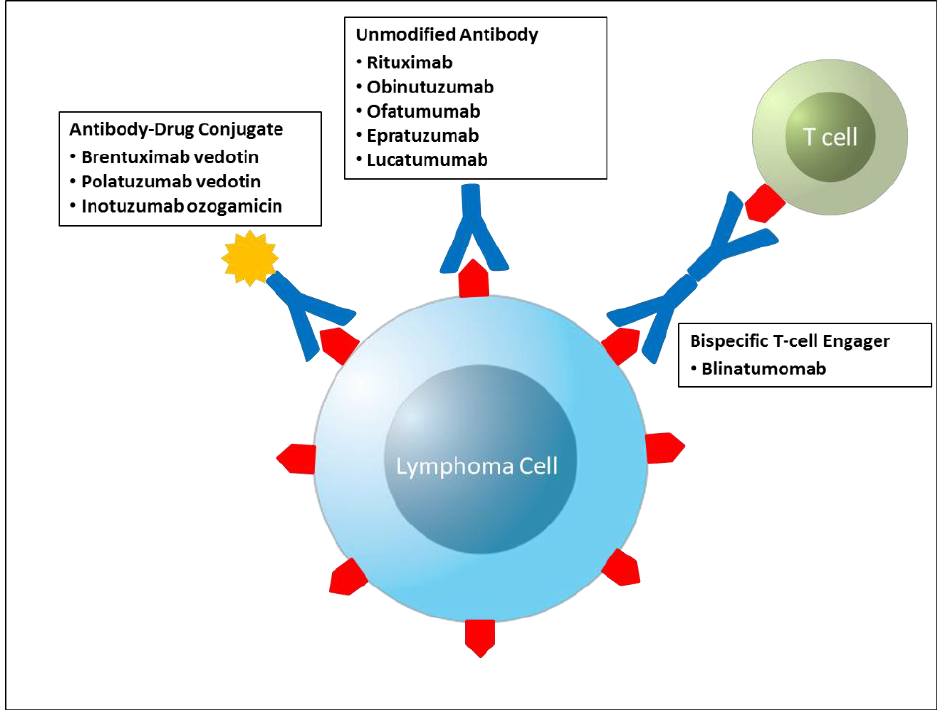
Figure 1. Schematic representation of the antibody based therapies discussed in this